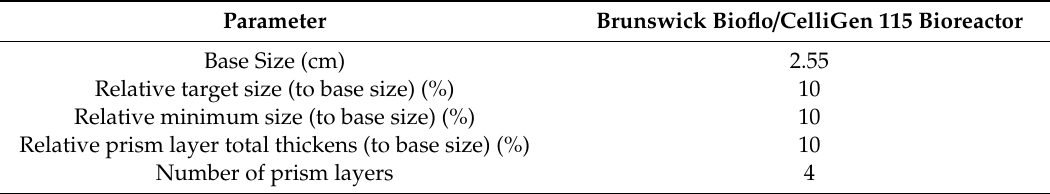
Table 3. Mesh configuration for CFD simulation of Brunswick Bioflo / CelliGen 115